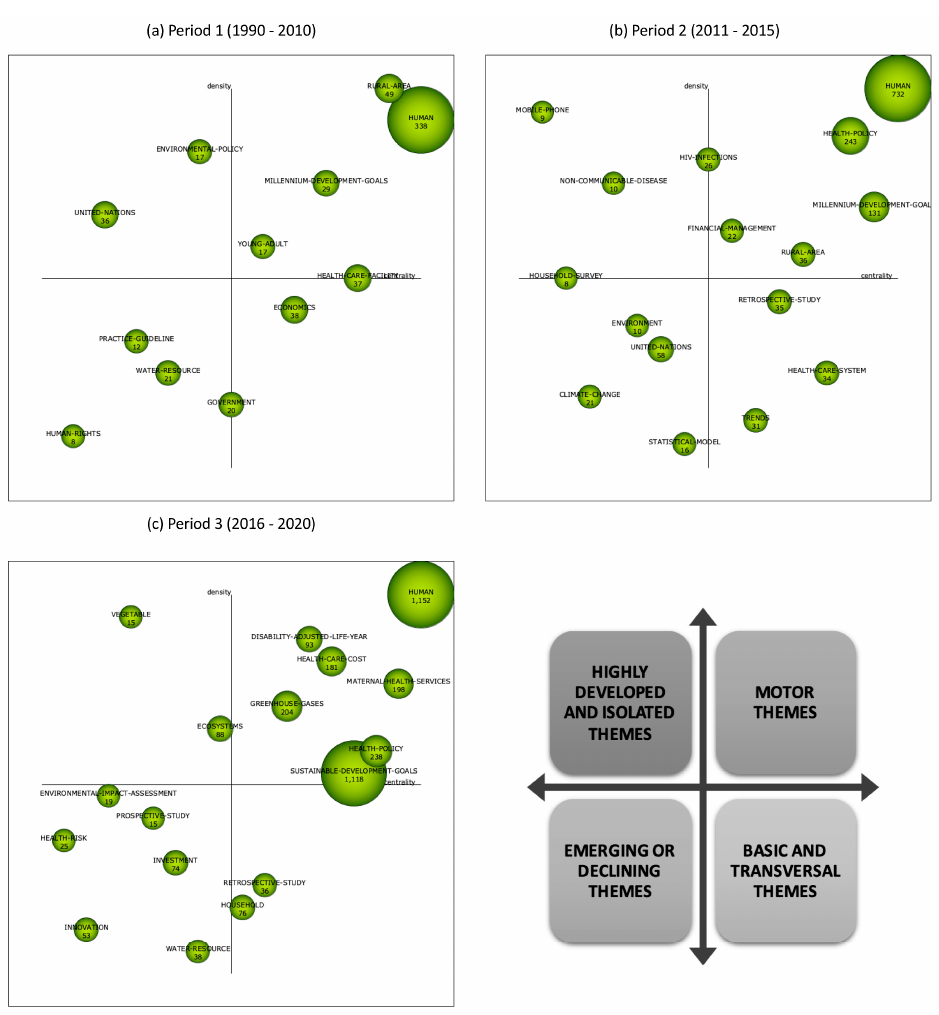
Figure 4. Strategic diagrams for ( a ) period 1, ( b ) period 2 and ( c ) period 3.